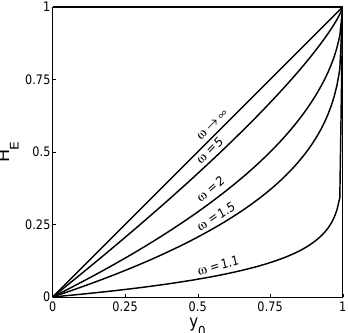
Figure 5. Relationship (Eq. 23) between the parameter H E of the ML formulation (Eq. 14a) and the parameter y 0 of the Greve et al. (2016) (Eq. 22) for different values of ω with ω = κ .